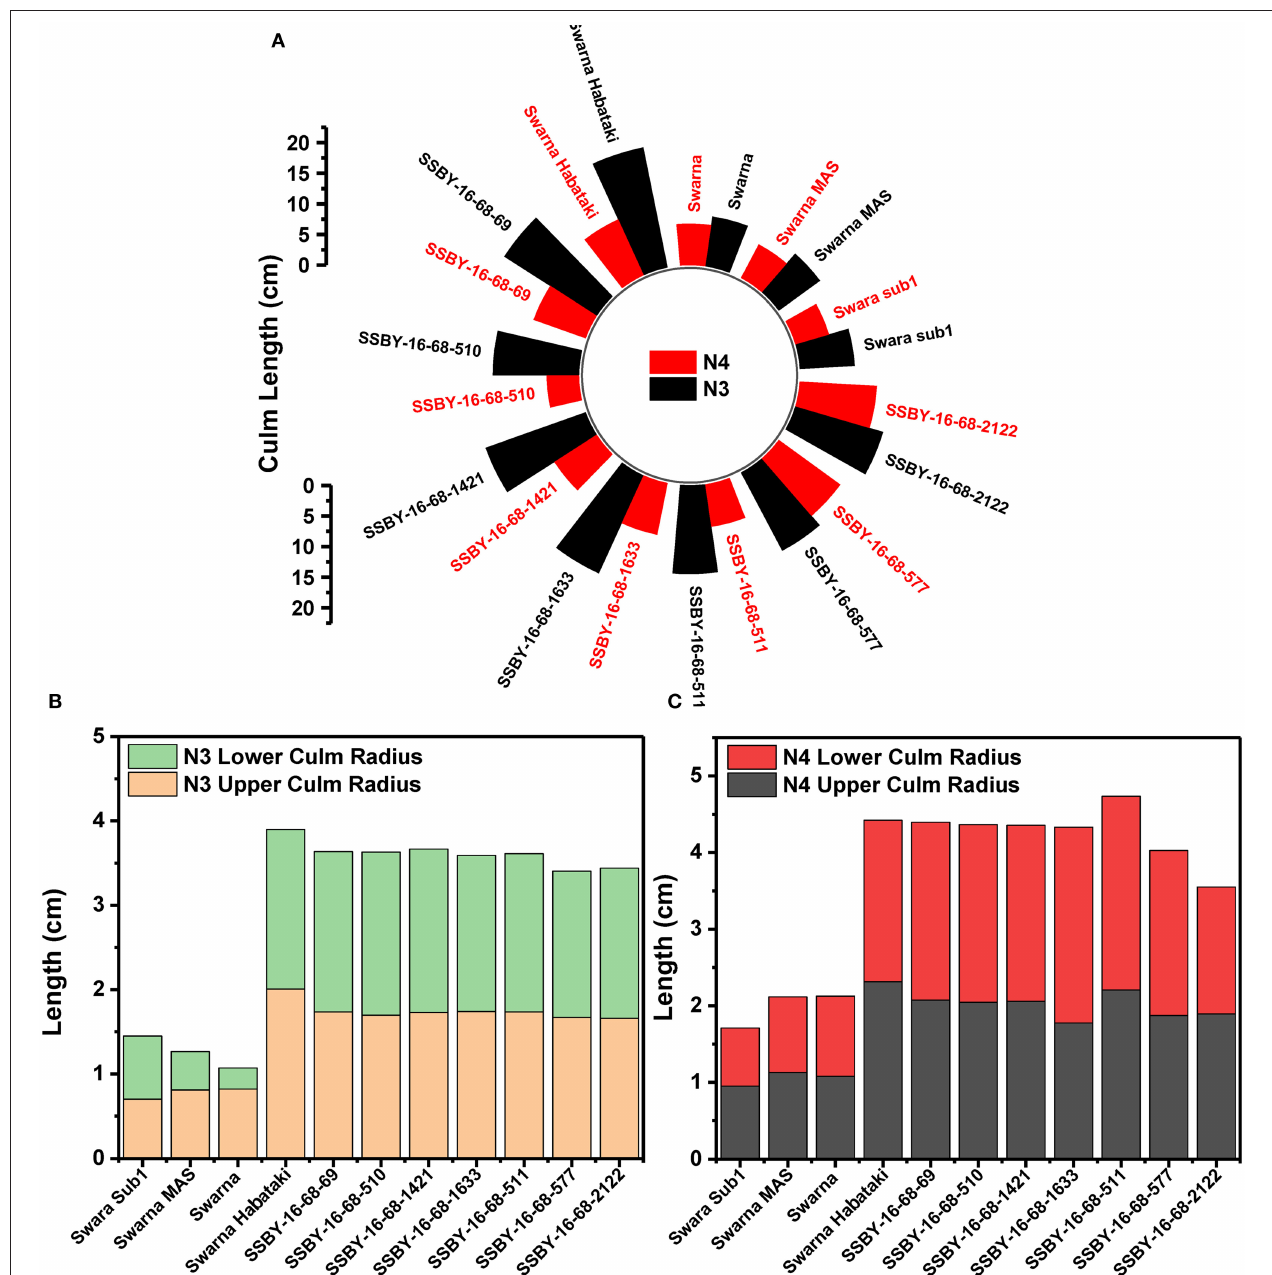
FIGURE 8 | The graphs represent (A) culm length and radius of the culm at both upper and lower end of the (B) internode N3 and (C) internode N4 in the seven pyramided lines and four parental lines.